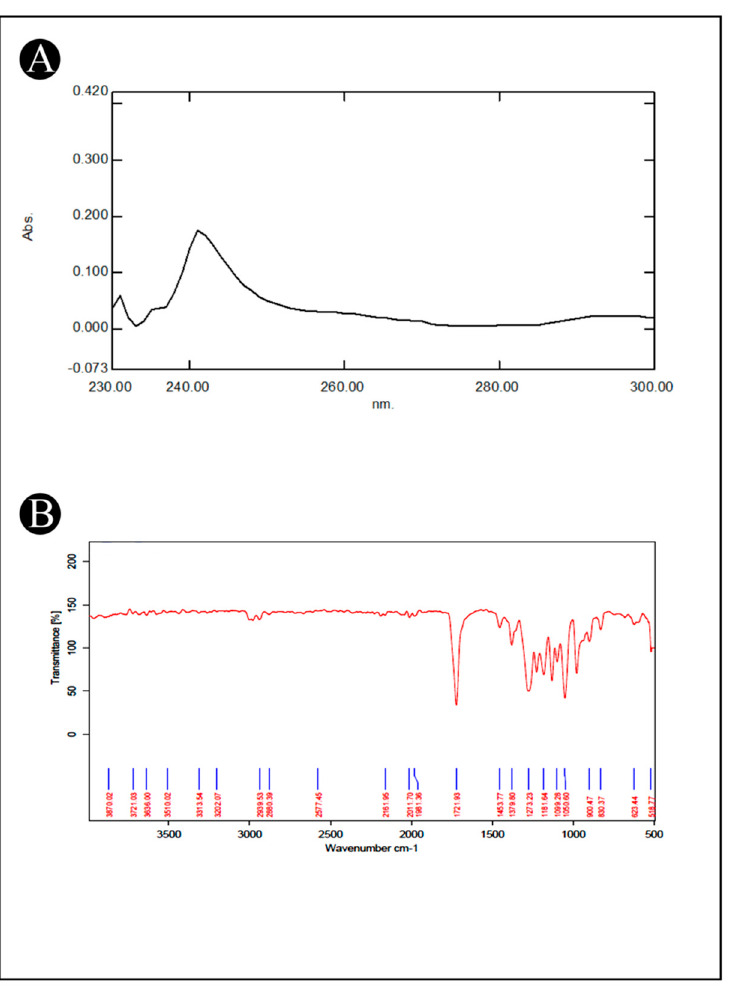
Figure 2. ( A ) UV–Vis spectrophotometer scanning spectrum of extracted PHB from B. flexus strain HSA3; ( B ) FTIR analysis of the extracted PHB from B. flexus strain HSA3.